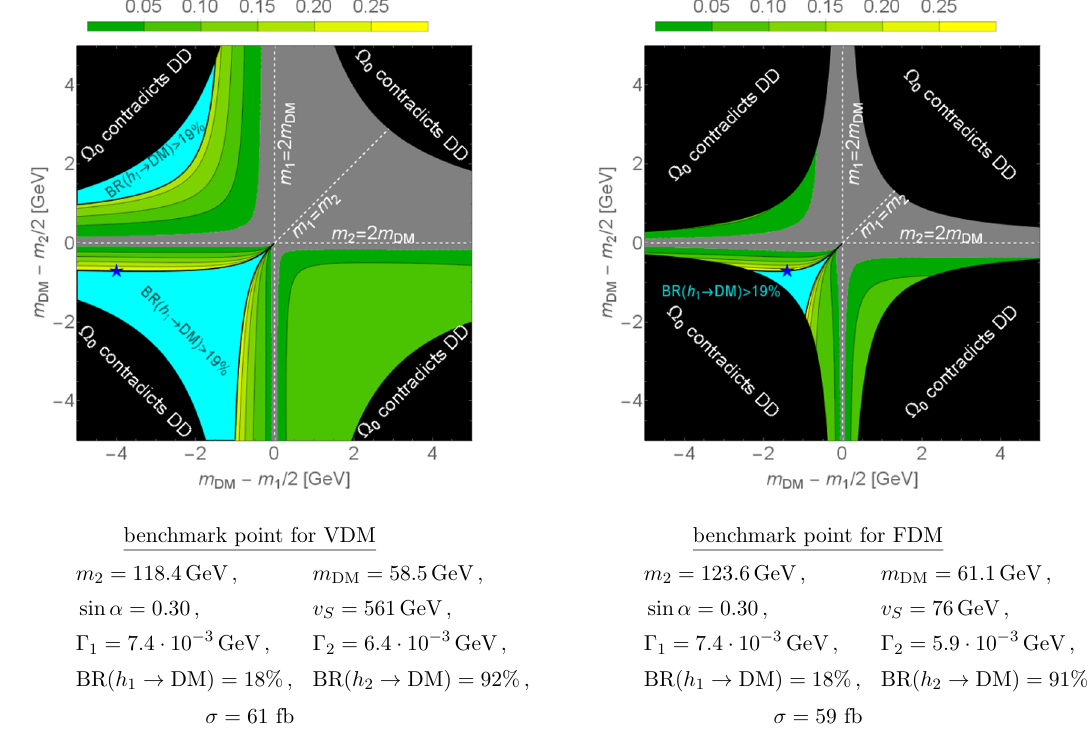
Figure 10 . As in (cid:12)gure 9 for the VDM model (left) and the FDM model (right). The region forbidden by the DD constraint is denoted by black